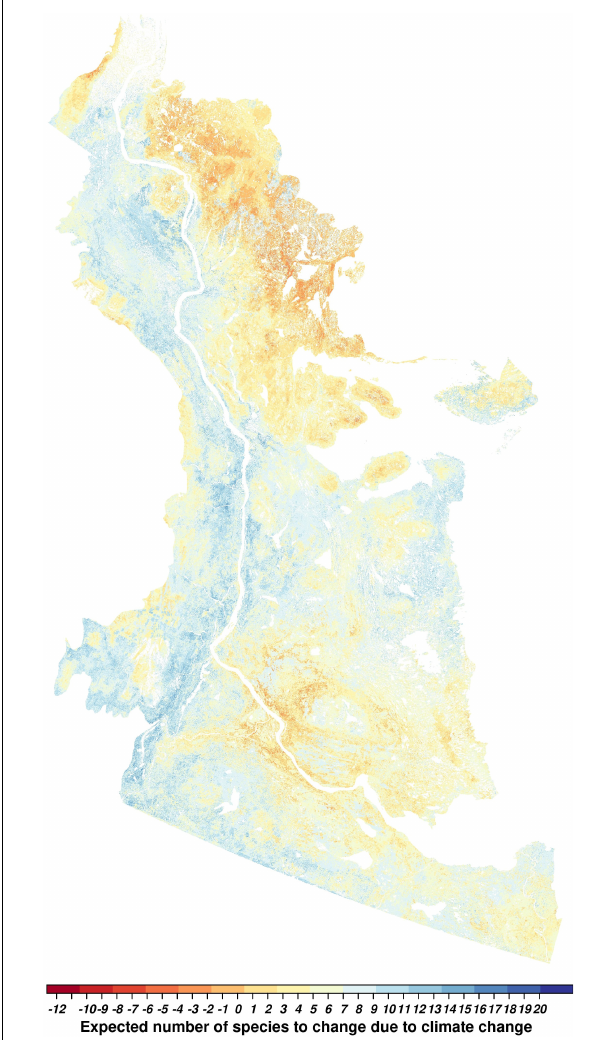
FIGURE 7 | Expected change in the number of species due to net effects of climate change (difference of the change from 2011 to 2100 between full climate-sensitive models and full non-climate-sensitive models) in the Taiga Plains ecozone within the Northwest Territories, Canada. Yellow to red values represent species losses, and yellow to blue values represent species